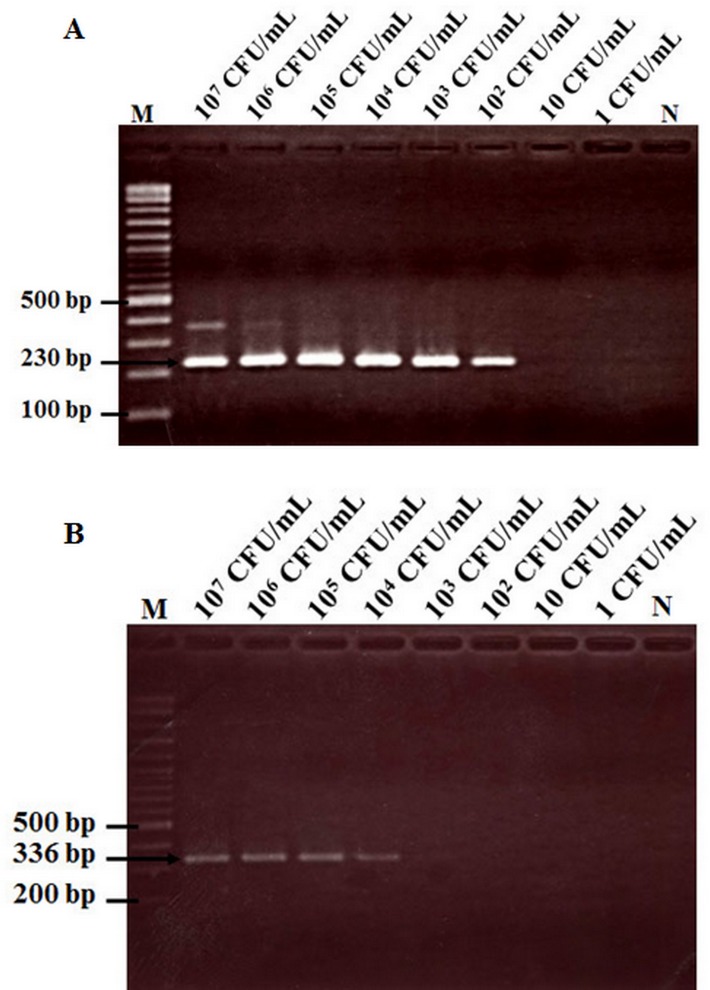
Comparison of a sensitivity test carried out using total DNA template as in Fig 5 with traditional PCR methods.(A) Nested PCR followed by AGE (AP4 method). (B) 1-step PCR followed by AGE (AP3 method). Lane M: 2 log DNA marker and N: 100 ng of DNA extracted from normal shrimp.